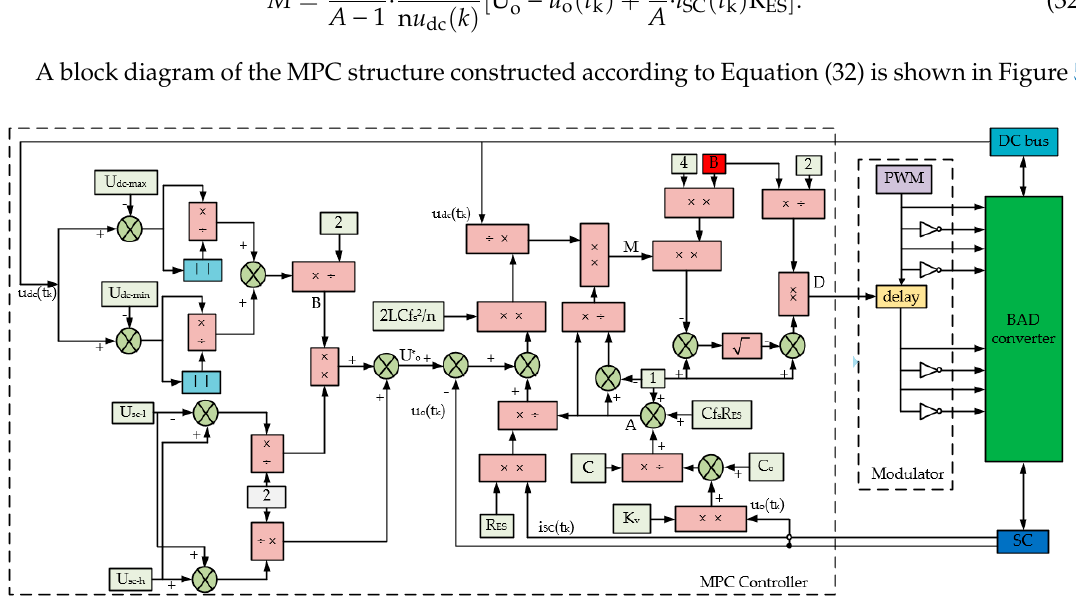
Figure 5. MPC structure block diagram.